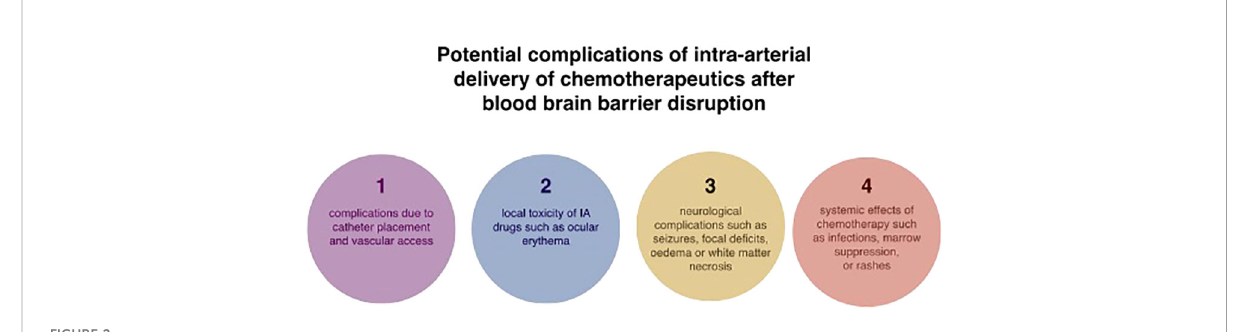
FIGURE 2 Potential complications associated with intra-arterial drug delivery of chemotherapeutics in the treatment of